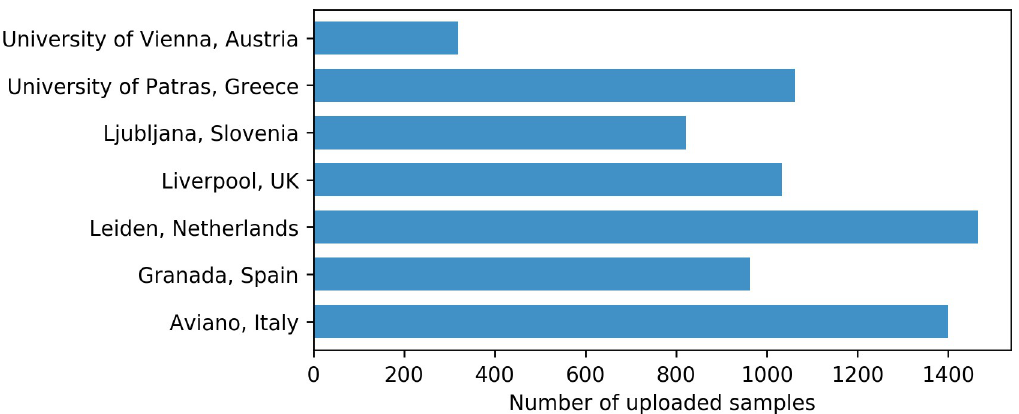
Fig 4. Number of genotyping samples uploaded per country as of March 2021. Processing of samples of control arm patients was still ongoing at the time of writing.